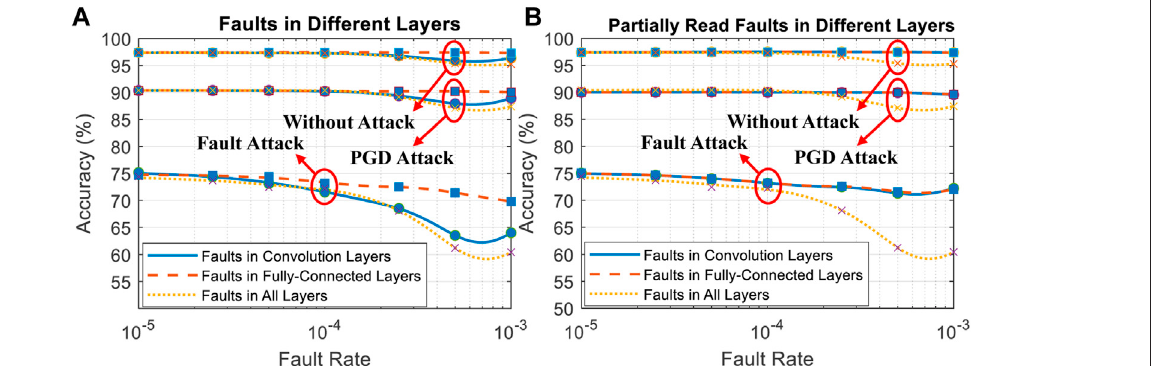
FIGURE 9| (A) Results ofattack Model 5, in which all faults in the chip are known, (B) results of attack Model 5, in which only the faults in certain layers are known.